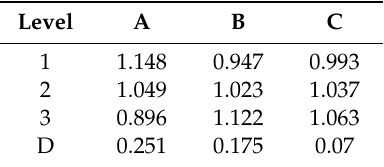
Table 4. Results of the range analysis of the maximum